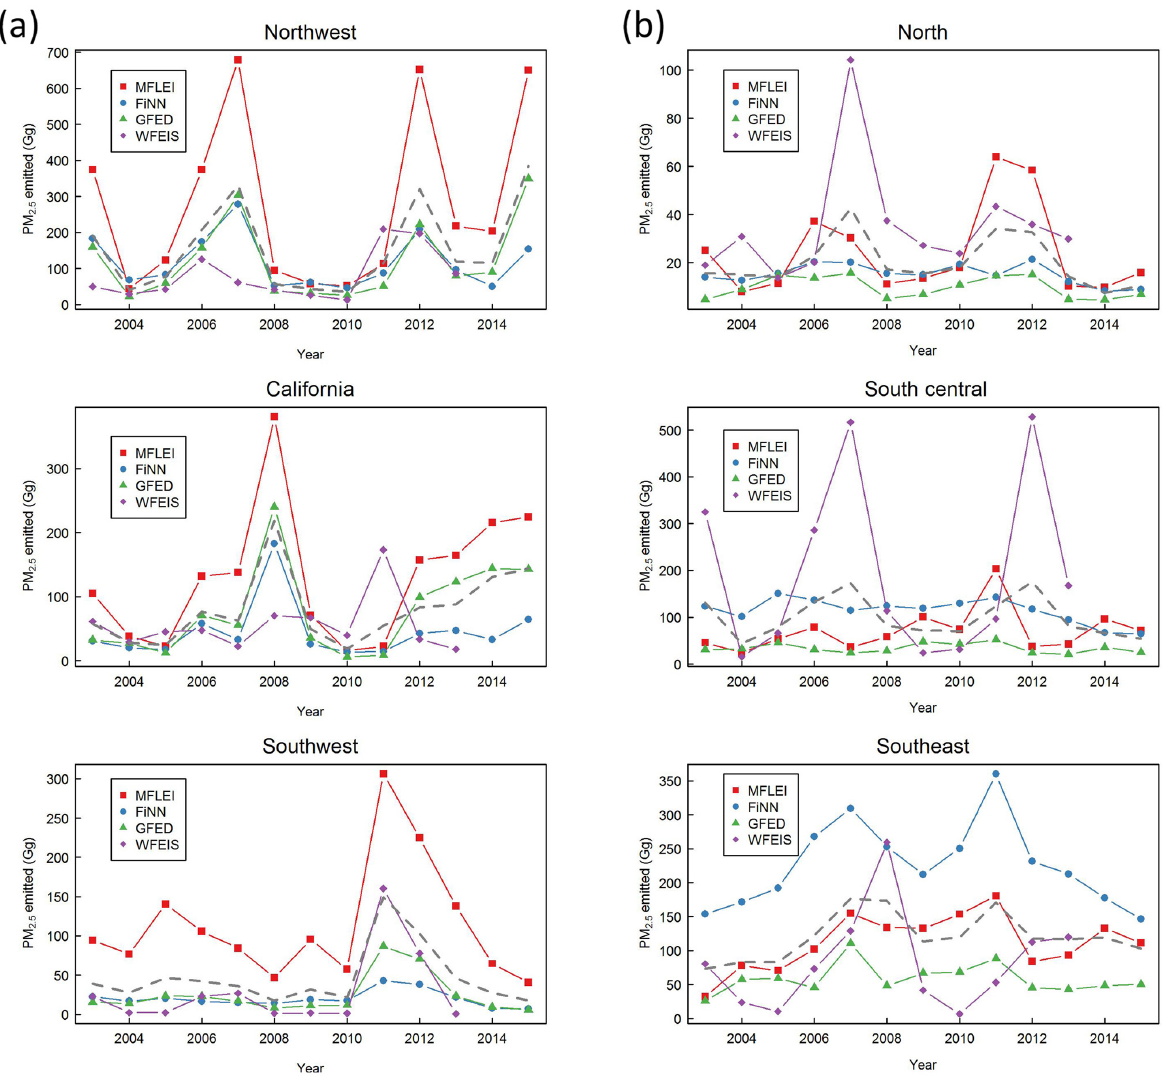
Figure 23. Annual PM 2 . 5 emitted from MFLEI, FINN v1.5, GFED v4.1s, and WFEIS v0.5 for (a) northwest, California, and southwest regions and (b) north, south-central, and southeast